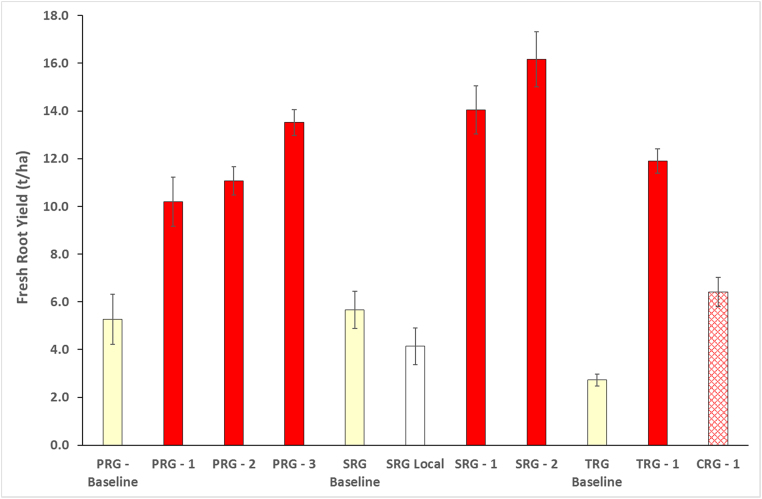
Fresh root yields recorded from farmer groups in Chato for PRG, SRG, TRG and CRG plantings. Baseline yields were recorded in local varieties grown in PRG, SRG and TRG locations prior to the commencement of community phytosanitation and the introduction of disease-free Mkombozi. The SRG local fields were cultivated with local varieties and monitored in parallel with PRG Mkombozi fields prior to the start of community phytosanitation in the SRG area.